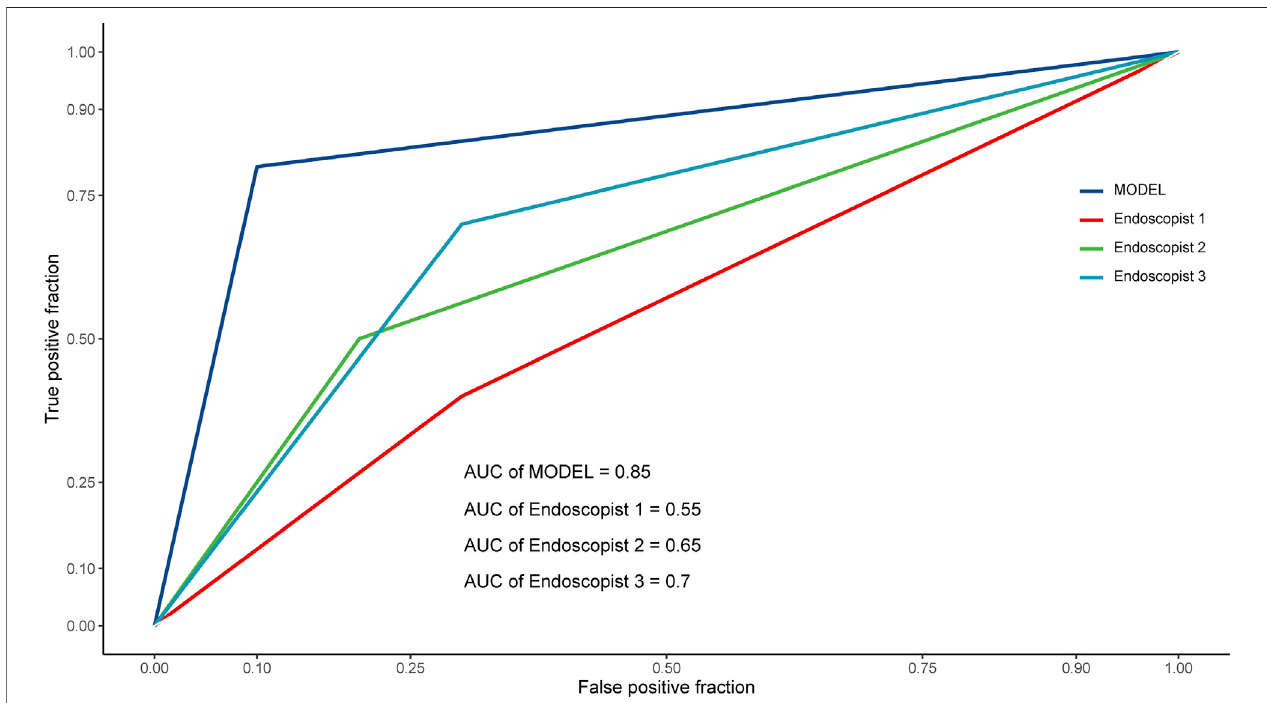
FIGURE 5 | ROC curves of the reader study. ROC, receiver operating characteristic; AUC (AUROC), area under the receiver operating characteristic curve.